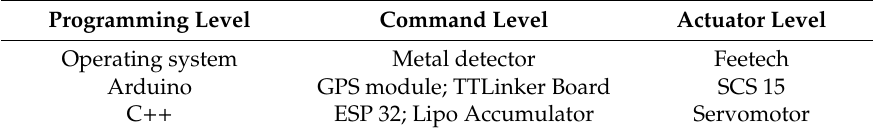
Table 1. Specific data regarding the robotic vehicle materials used for research.